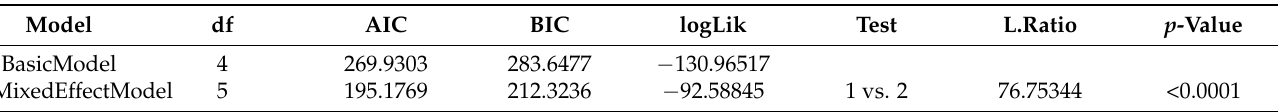
Table 3. ANOVA analysis to compare the